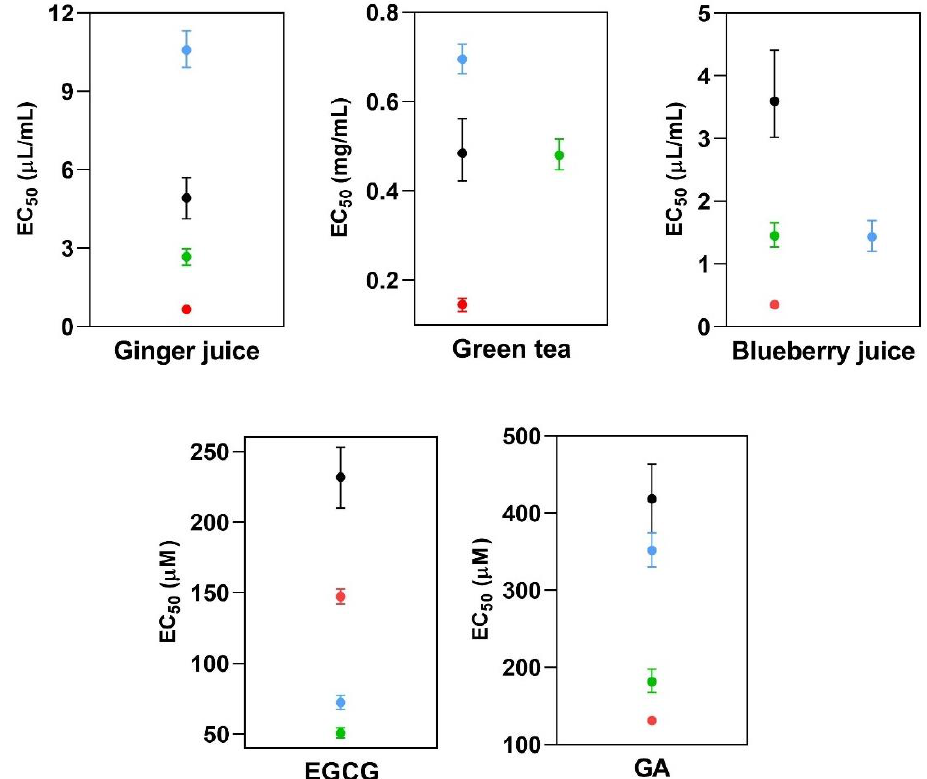
Figure 4. Graphical representation of EC 50 and the corresponding CI 95% values for each plant juice, infusion and chemical compound. Each point represents a hydroxyl radical-generating system: Fe(II)/phosphate buffer ( ● ), Fe(II)/Quin/phosphate buffer ( ● ), Fe(II)/Quin ( ● ), thermal degradation of peroxydisulfate ( ●